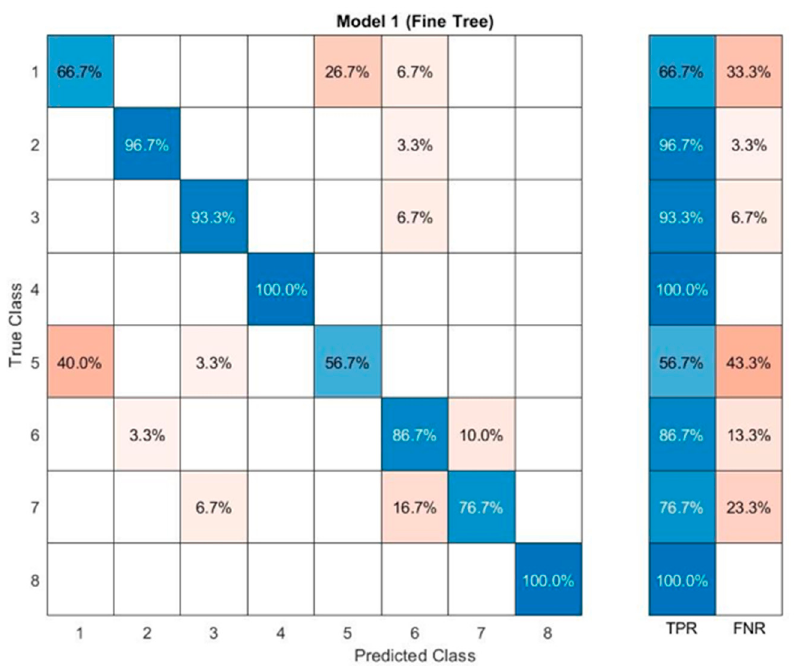
Figure 5. Classification of non-adjusted dataset with fine tree machine-learning-model confusion matrices.